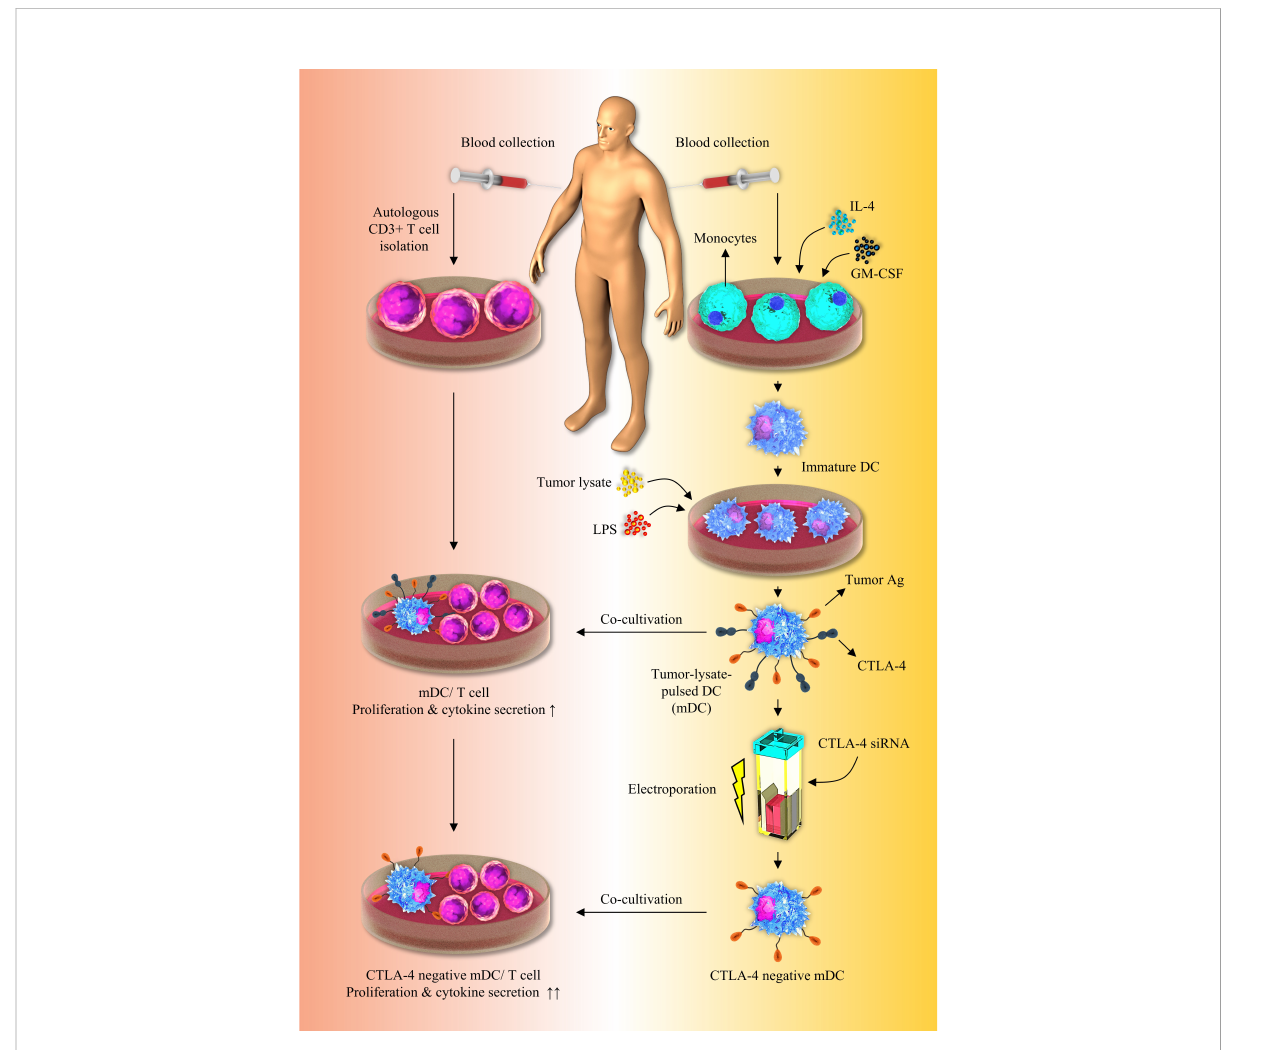
FIGURE 6 Inhibition of CTLA-4 molecules augments T-cell responses to tumor-lysate-pulsed-DCs. Silencing of CTLA-4 gene in DCs via using siRNA improves their stimulatory properties. Co-culture of tumor-lysate-pulsed CTLA-4-scilenced DCs with CD3 + T cells improves T-cell mediated responses. CTLA-4, Cytotoxic T-lymphocyte-associated protein-4; DC, dendritic cell; siRNA, small interfering